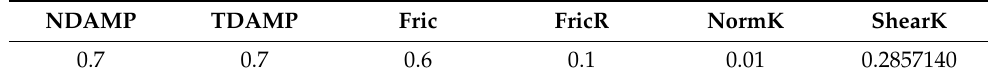
Table 2. *CONTROL_DISCRETE_ELEMENT.